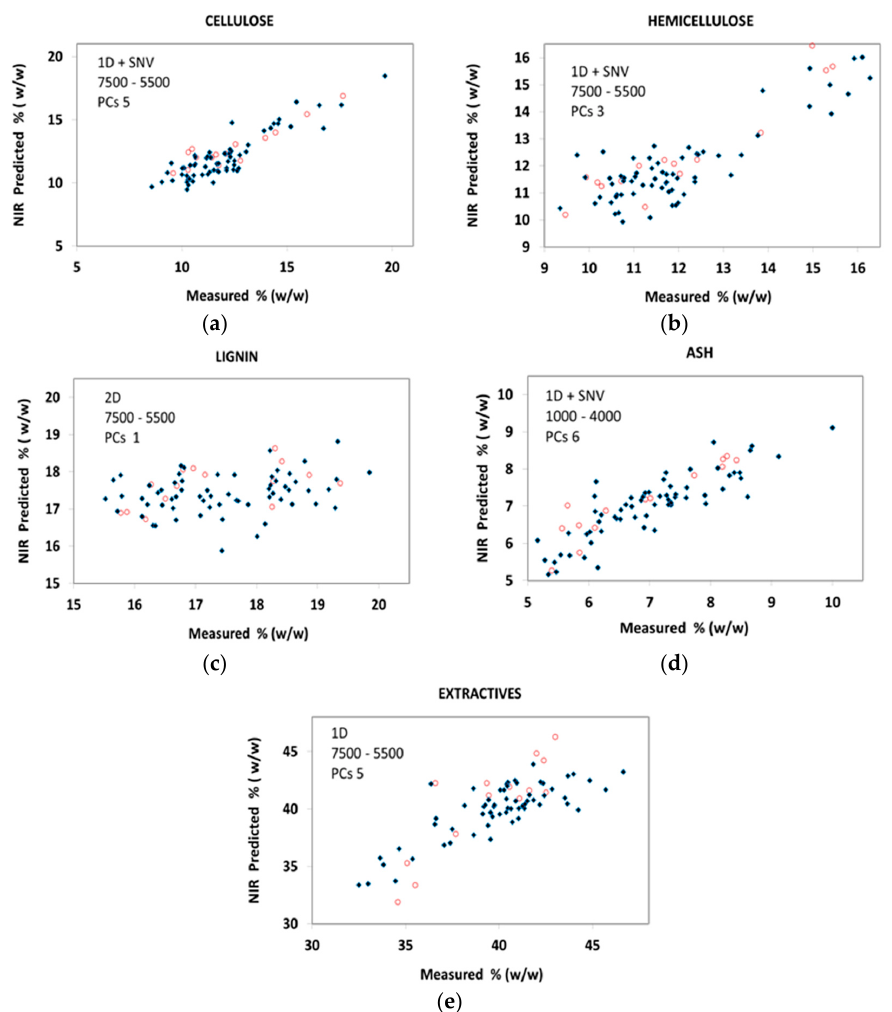
Figure 2. Near infrared (NIR)-predicted vs. measured plot of cellulose ( a ), hemicellulose ( b ), lignin ( c ), ash ( d ) and extractives ( e ) content in olive tree pruning: ( ♦ ) cross validation and ( ○ ) external ash ( d ) and extractives ( e ) content in olive tree pruning: ( (cid:7) ) cross validation and ( validation.